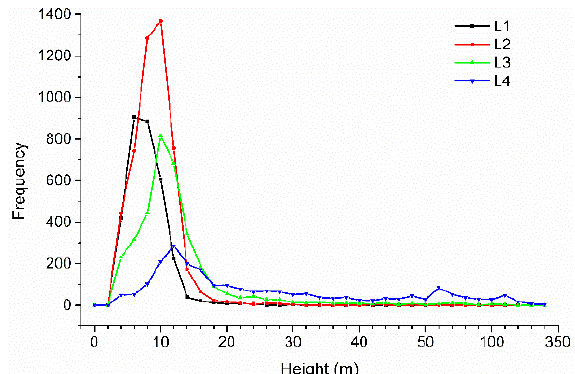
Figure 7. Building height distribution comparison among four block FAR